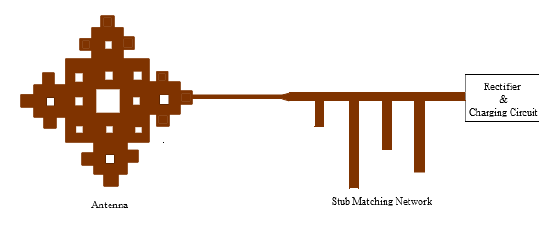
Figure 1: RF energy harvesting